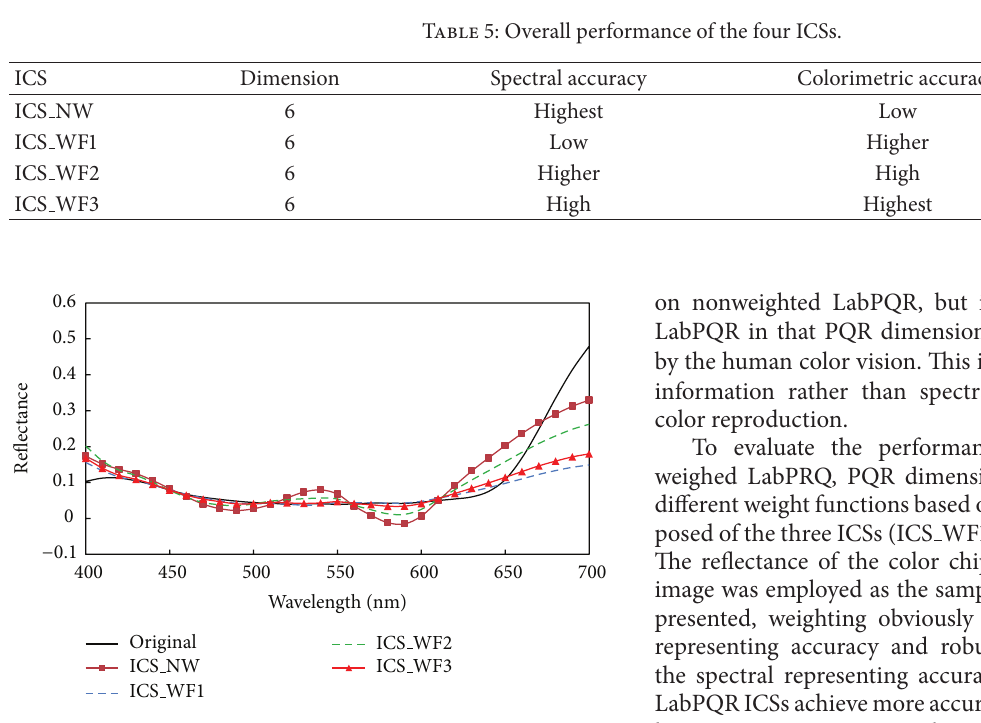
Figure 2: Example of the spectral reconstructions of one Munsell